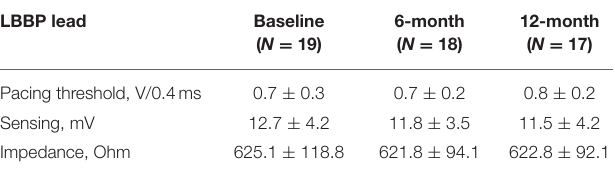
TABLE 2 | Lead parameters at the baseline and during the follow-up. LBBP